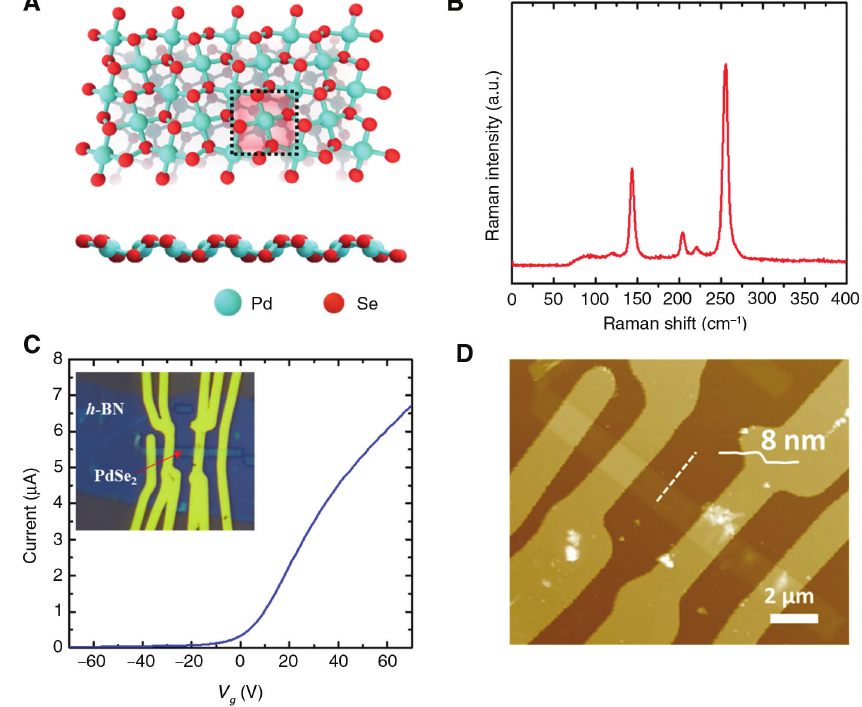
flake. 2 flake used to make phototransistor. (C) Typical FET 2 = 0.5 V. Inset: Optical image of the measured PdSe phototransistor with V 2 sd flake to be 8 2